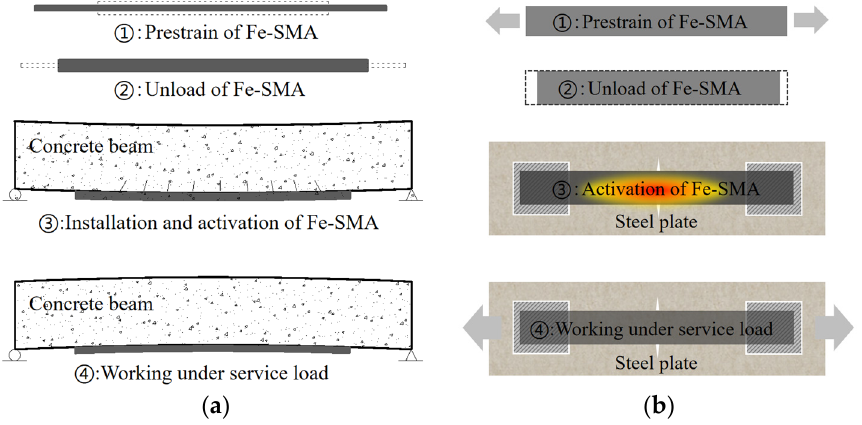
Figure 7. Reinforcement process with Fe-SMA: ( a ) concrete beam, ( b ) cracked steel plate.